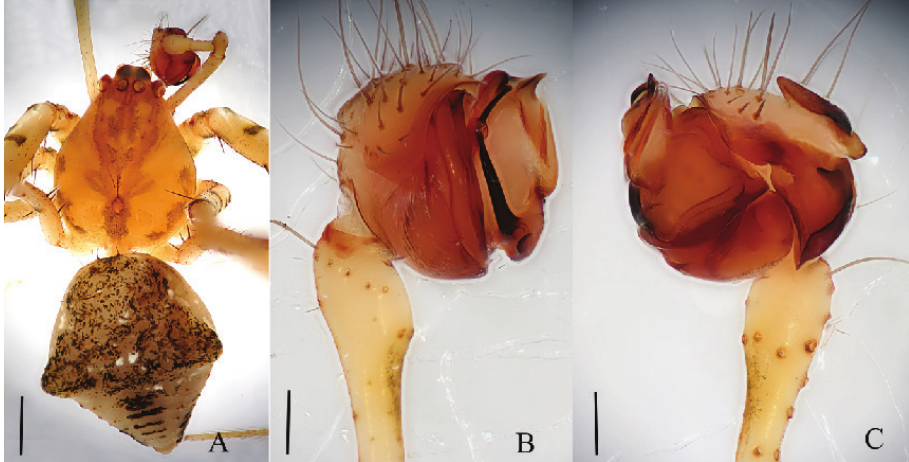
Figure 7. Mimetus wangi sp. n., holotype male. A habitus, dorsal view B palp, prolateral view C palp, retrolateral view. Scale bars: A , 0.5; B–C , 0.1.